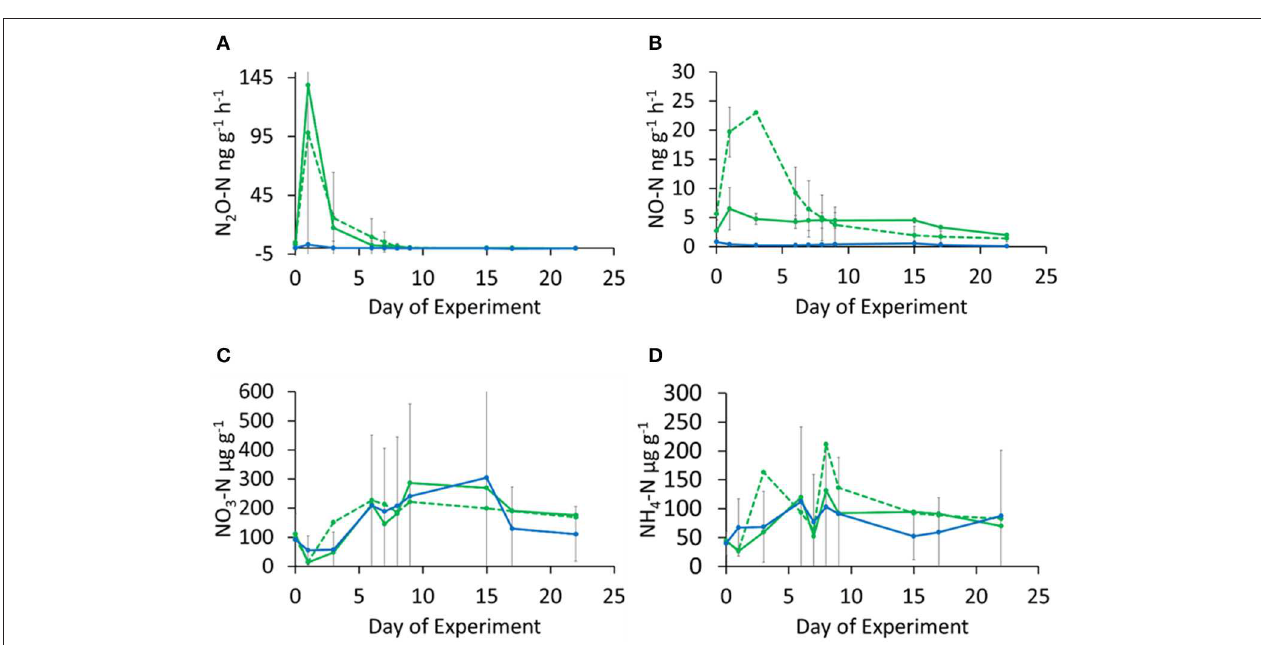
FIGURE 3 | Temporal changes in N 2 O (A) and NO (B) emission rates and soil NO − 3 (C) and NH + 4 (D) concentrations in logged forest (LFE: solid green circles, dashed green line and E: solid green circles, solid green line) and riparian reserve (RR: solid blue circles, solid blue line) soils. Error bars represent standard deviation of means from triplicate incubations. Soils were rewetted at day-0 with N supply at 5kg N ha − 1 equivalent to field N deposition